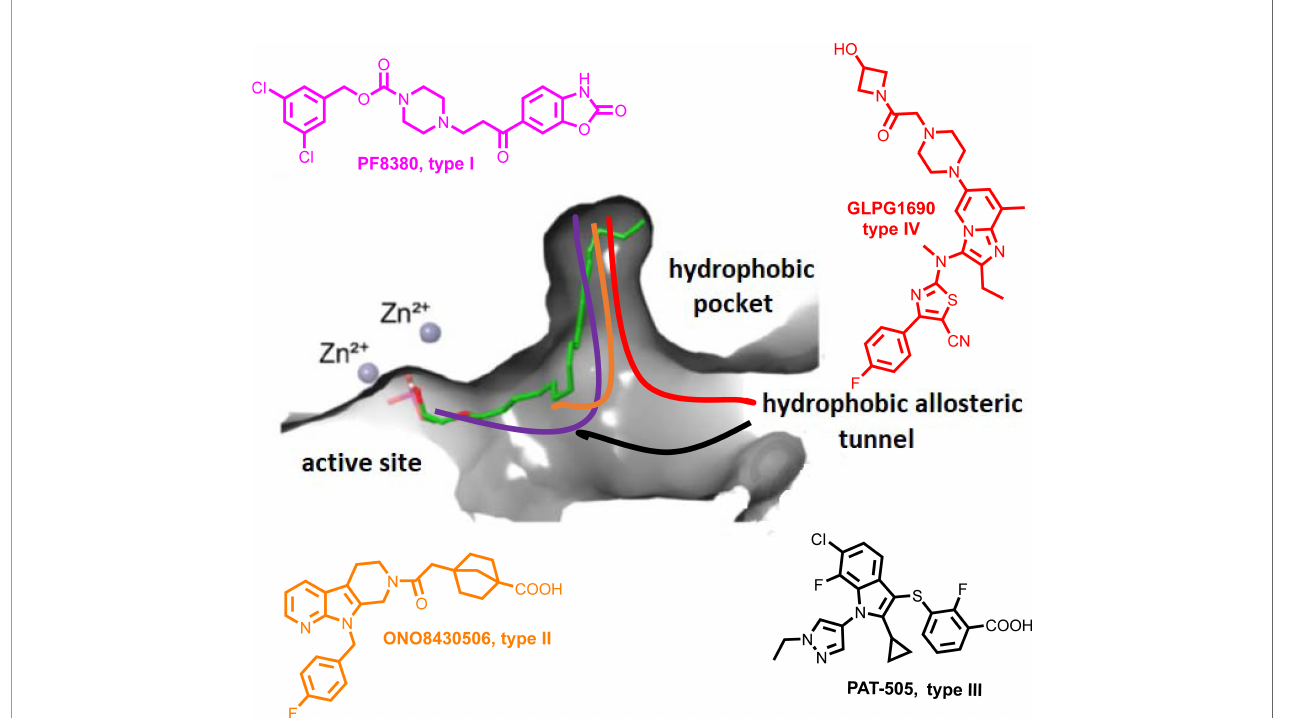
FIGURE 1 | Schematic representation of the mode of binding (color coded) to ATX by the 4 different types of ATX inhibitors (I-IV). The mode of binding of LPA is also displayed (in